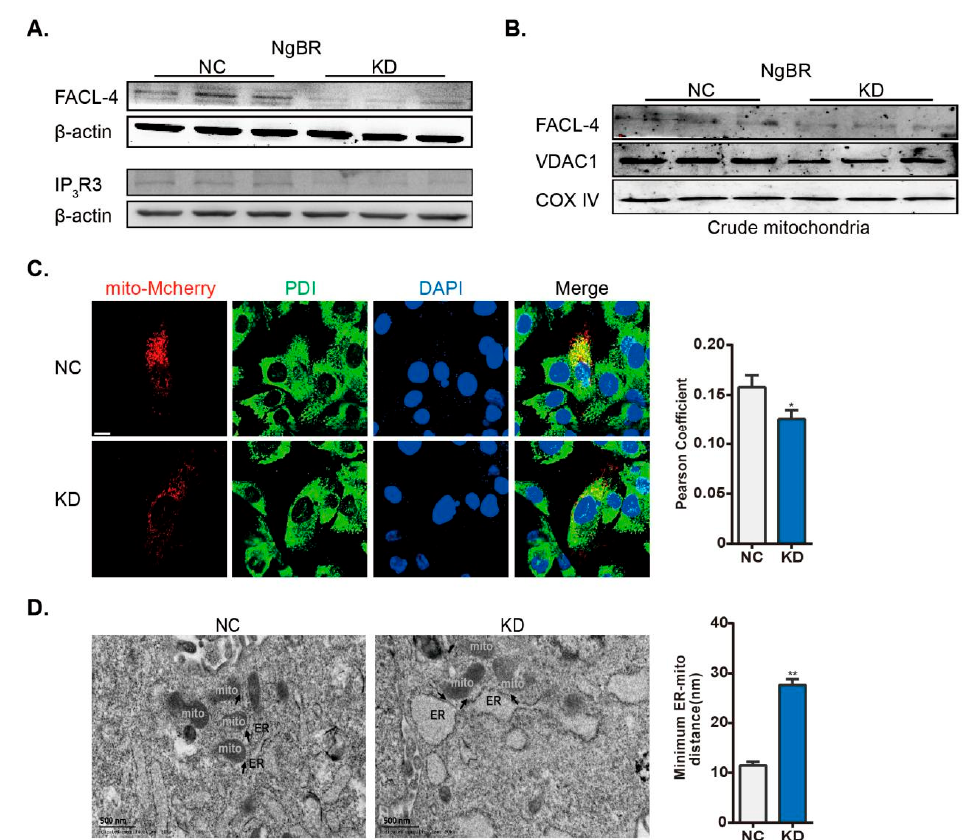
Figure 3. NgBR KD cells show disrupted ER-mitochondria interaction. shControl- and shNgBR- transfected cells were harvested at 48 h post transfection. MAM formation was analyzed by evaluating the expression of MAM-related proteins in ( A ) total cell lysates (FACL-4 and IP 3 R3) and ( B ) crude mitochondrial extracts (FACL-4 and VDAC1); β -actin and COX IV were utilized as the loading controls, respectively. n = 3. ( C ) Cells were incubated with plasmid expressing mCherry fused with a targeting sequence of subunit IV of COX prior to shRNA transfection. PDI was used as an ER marker. Nuclei were stained with Hoechst (blue). Pearson’s correlation coefficient was calculated to measure colocalization of ER and mitochondria on mCherry positive cells. n > 60 cells / group. Scale bar = 10 µ m. ( D ) Transmission electron microscopy of negative control (NC; left) and NgBR knockdown KD (right) VSMCs. Arrowheads indicate the MAMs. The minimum ER-mitochondrial distance was quantified. n > 80 ER-mitochondria contact points / group. Scale bar = 500 nm. * p < 0.05, ** p <